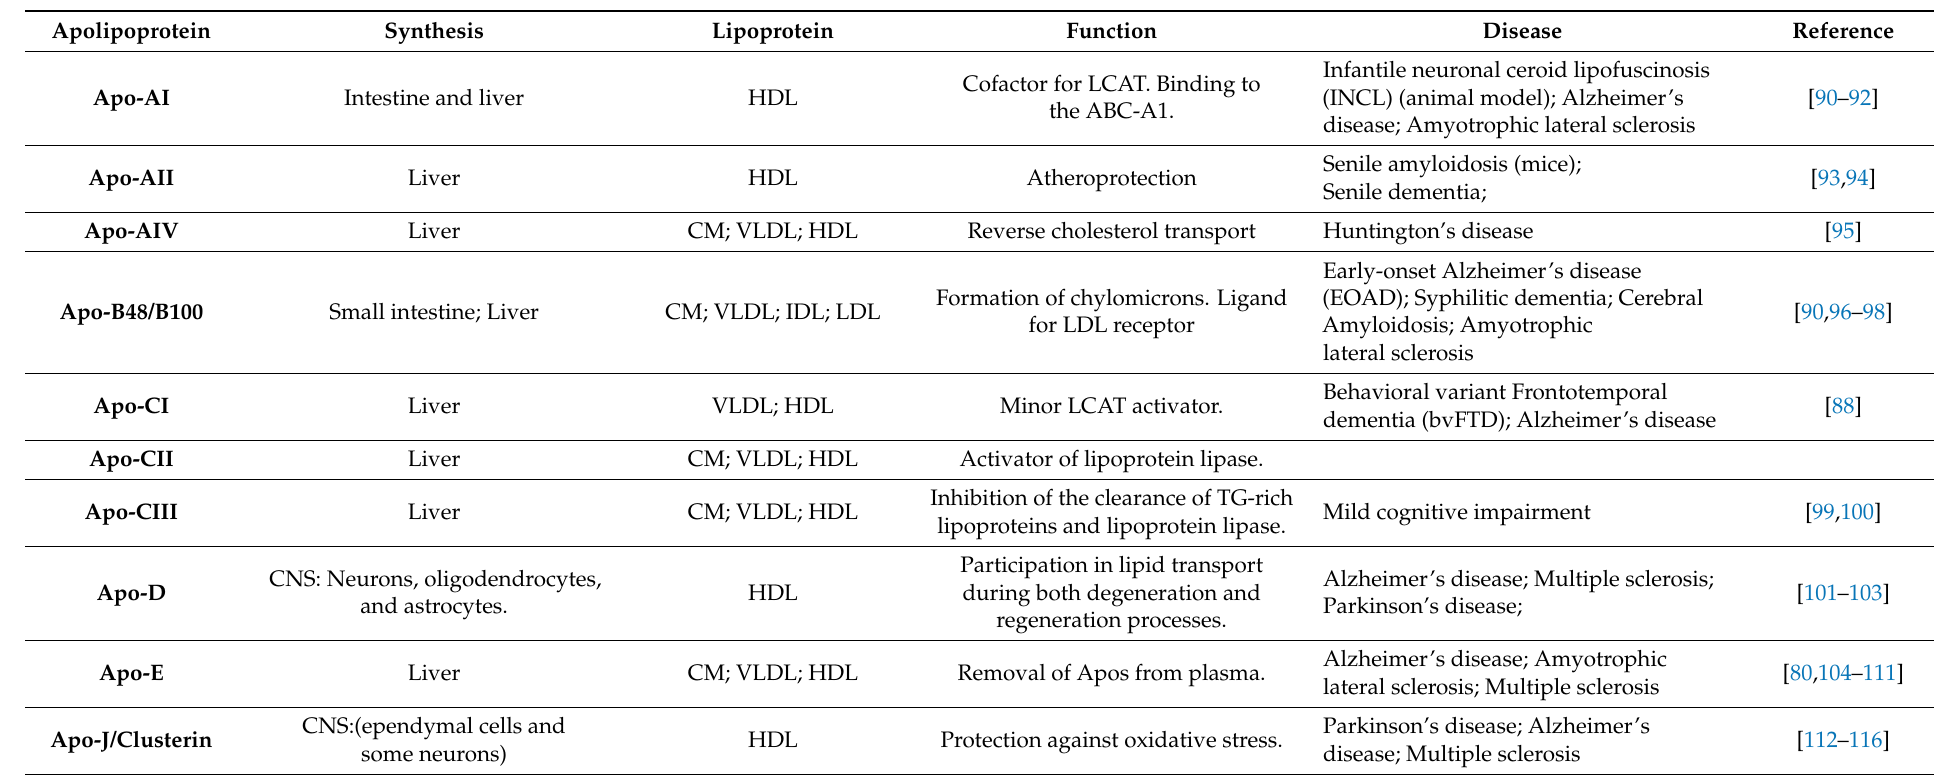
Table 1. Apolipoproteins and neurodegenerative